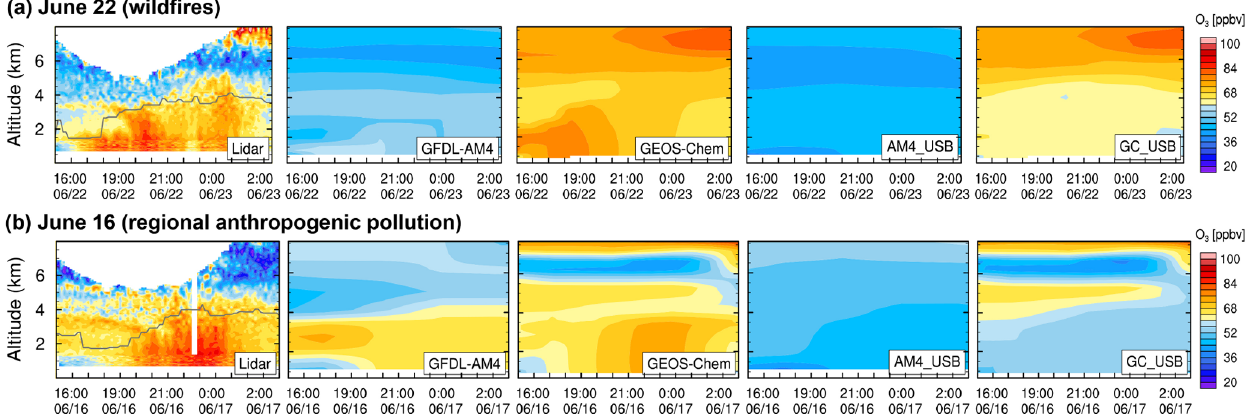
Figure 11. Same as Fig. 8 but for (a) the wildfire event on 22 June and (b) the regional anthropogenic pollution event on 16 June 2017 (UTC). The right panels compare USB O 3 from the two